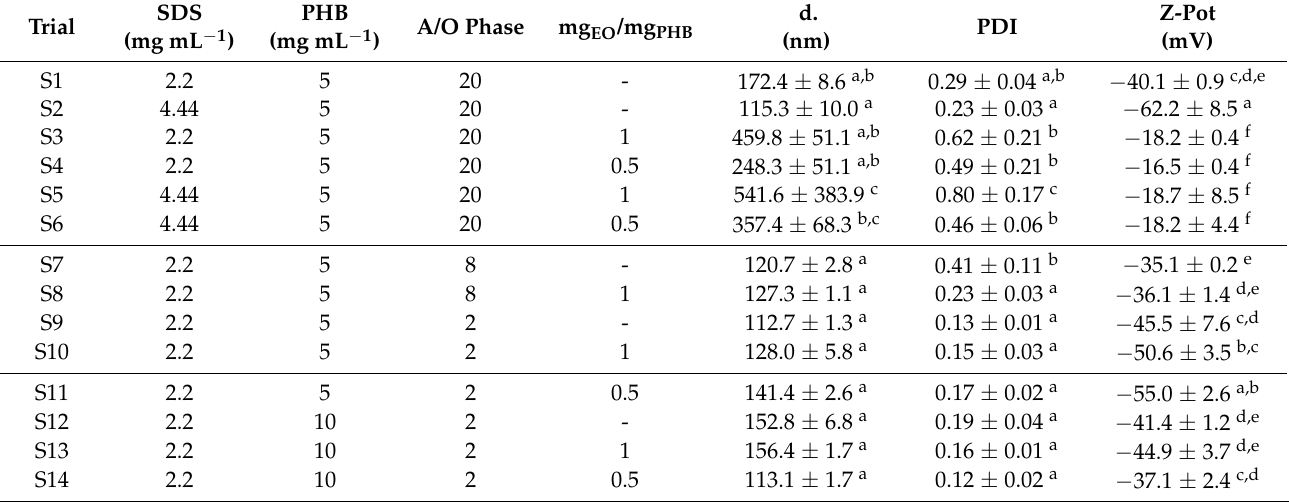
Table 1. Effect of different parameters on the synthesis of PHB-based nanoparticles. A/O, Aque- ous/Organic phase volume ratio, PDI, polydispersity index, d., diameter. Values are mean ± SD; the different letters indicate significant differences from the values reported in the same column (Tukey-Kramer test, p < 0.05). The different letters indicate significant